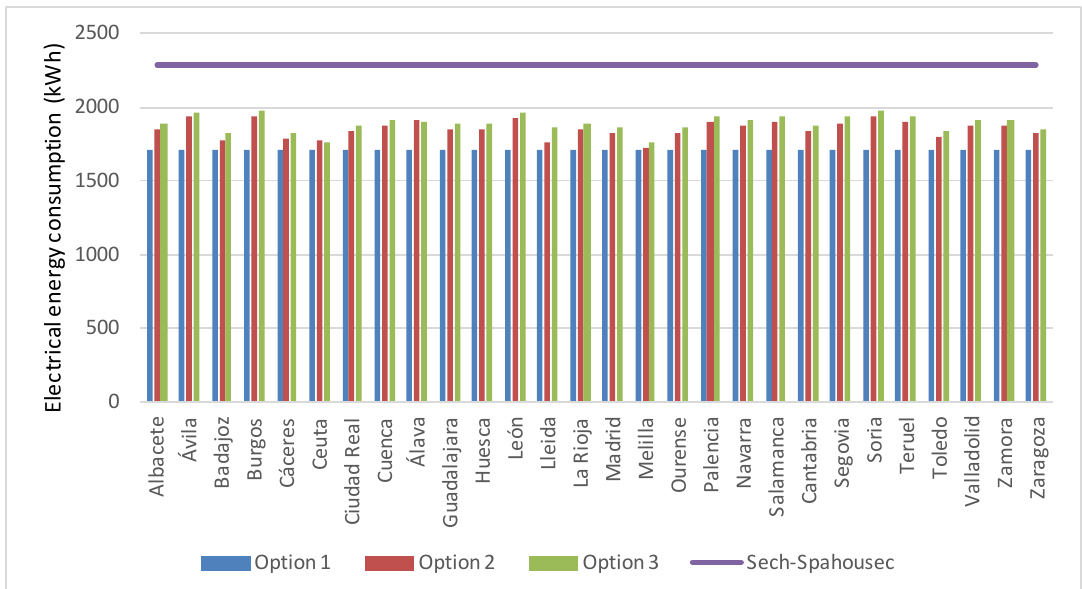
Figure 6. Average energy consumption kWh per house in a year